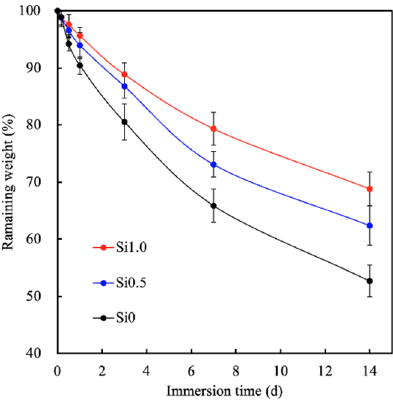
Figure 3. Degradation rates of the various Si-GelMa hydrogels after different durations of immersion.